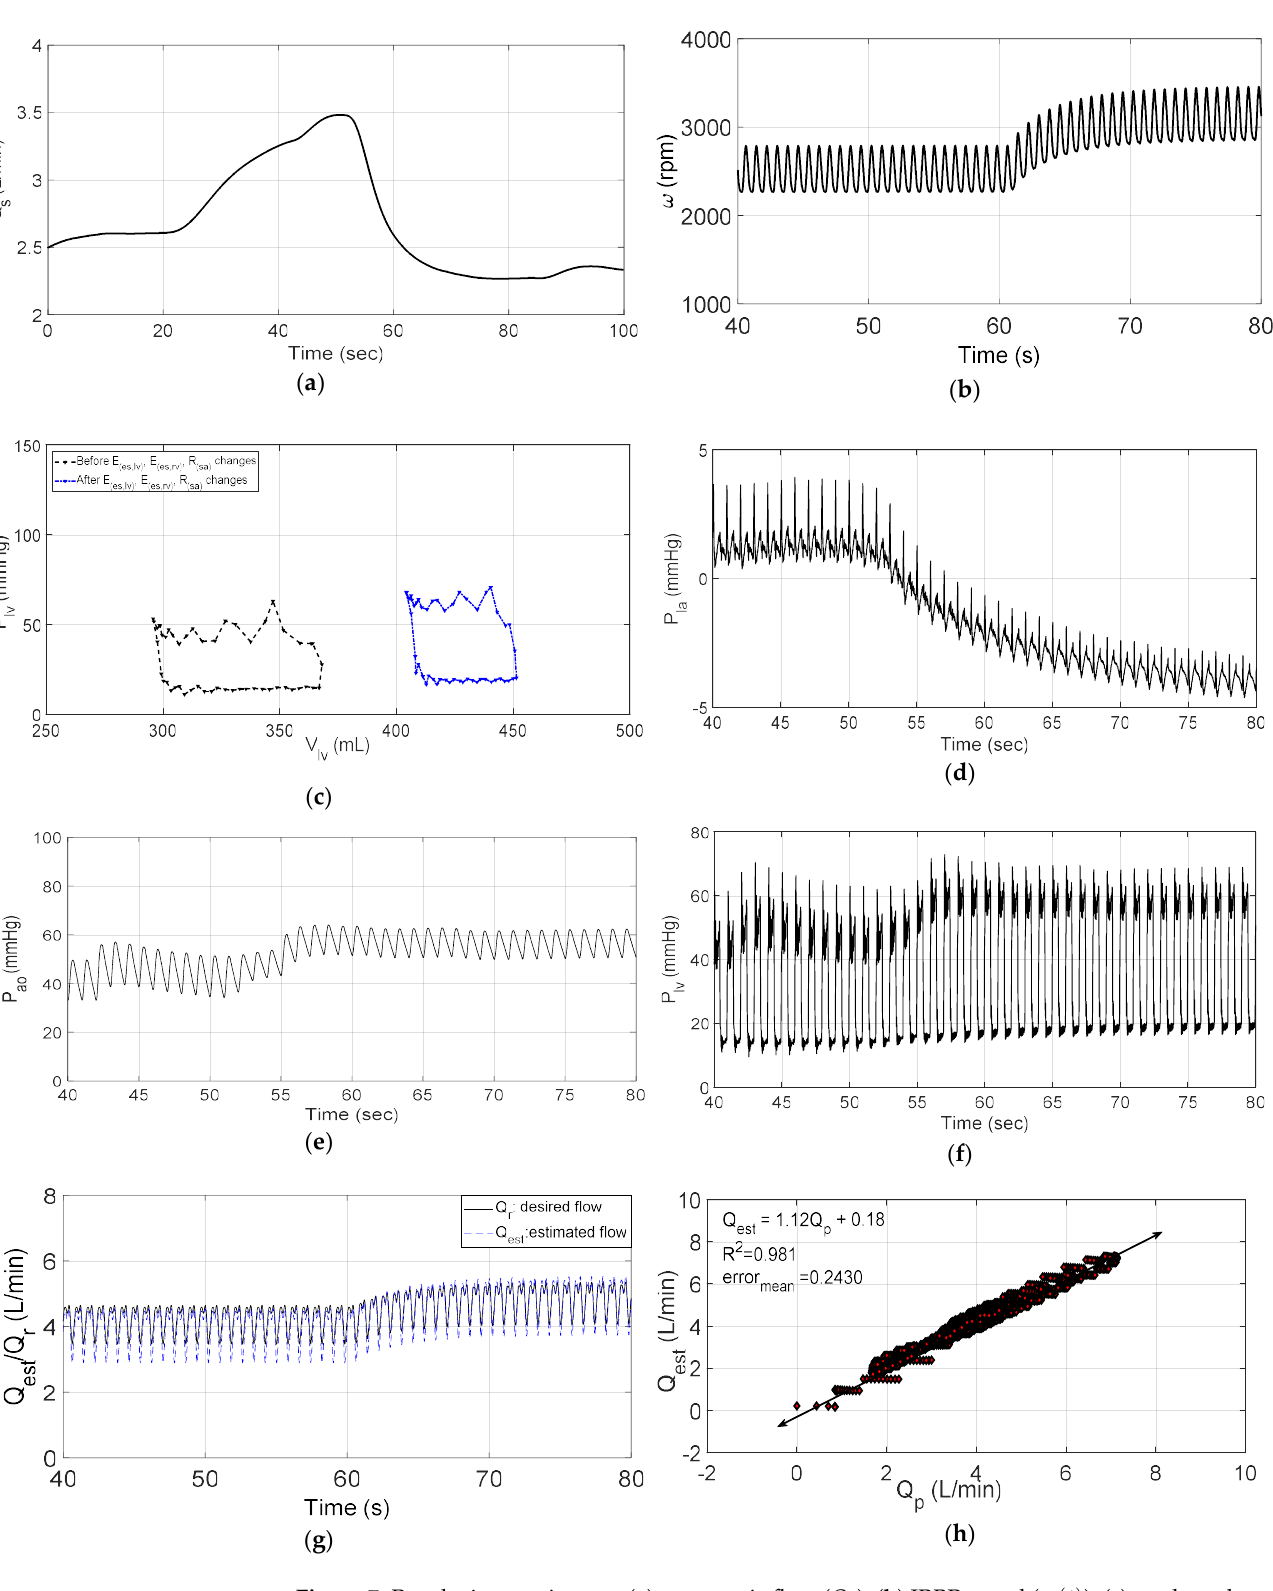
( h ) Figure 6. Results in relaxation test; ( a ) systematic flow ( 𝑄 (cid:3046) ); ( b ) IRBP speed ( 𝜔(𝑡) ); ( c ) stroke volume (SV); ( d ) left atrium pressure ( 𝑃 (cid:3039)(cid:3028) ); ( e ) aortic pressure ( 𝑃 (cid:3028)(cid:3042) ); ( f ) left ventricle pressure ( 𝑃 (cid:3039)(cid:3049) ); ( g ) esti- mated flow ( 𝑄(cid:3552) (cid:3032)(cid:3046)(cid:3047) ) vs. desired reference flow ( 𝑄 (cid:3045) ); ( h ) correlation between estimated flow ( 𝑄(cid:3552) (cid:3032)(cid:3046)(cid:3047) ) and actual flow ( 𝑄 (cid:3043) ). 3.3. Changes in Patient Parameters to Demonstrate an Exercise Test Figure 7 illustrates the waveforms of the model simulation during the changes in parameters for the CVS in the exercise test. In this test, 𝐸 (cid:3032)(cid:3046),(cid:3039)(cid:3049) and 𝐸 (cid:3032)(cid:3046),(cid:3045)(cid:3049) were increased by 20% and 𝑅 (cid:3046)(cid:3028) was reduced by 50% at 60 s over a period of 10 s. During this period, the closed-loop control system automatically activated to linearly track the increase in 𝑄 (cid:3045) from ( 3 + 4𝑠𝑖𝑛(2𝜋𝑡 𝑇⁄ ) ) to ( 3 + 4𝑠𝑖𝑛(2𝜋𝑡 𝑇⁄ ) ). During the exercise test, the controller responded to changes in the systematic flow from the initial value of 3.5 L/m to 2.8 L/min (Figure 7a) by increasing the pump speed from 2800 rpm to 3500 rpm (Figure 7b). These changes were associated with a decrease in the size of the stroke volume and shifted to the left by 210 mL (Figure 7c). As a result, the